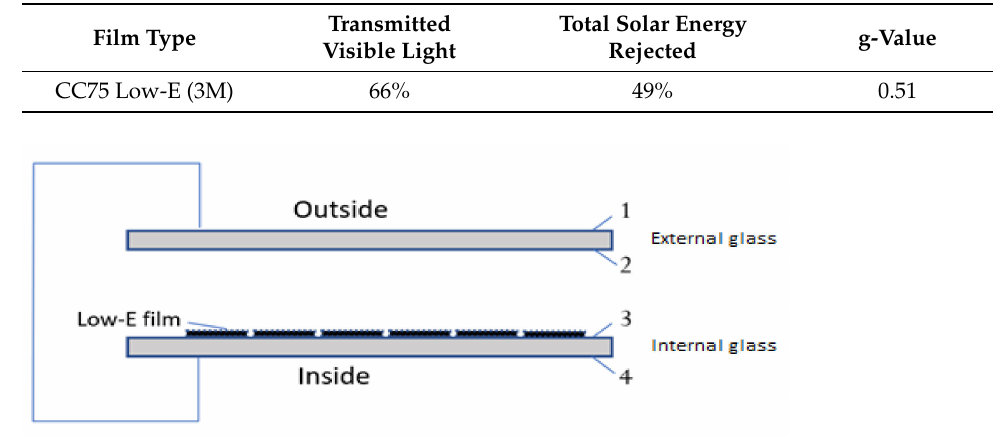
Figure 6. Position of the applied low-E film in the